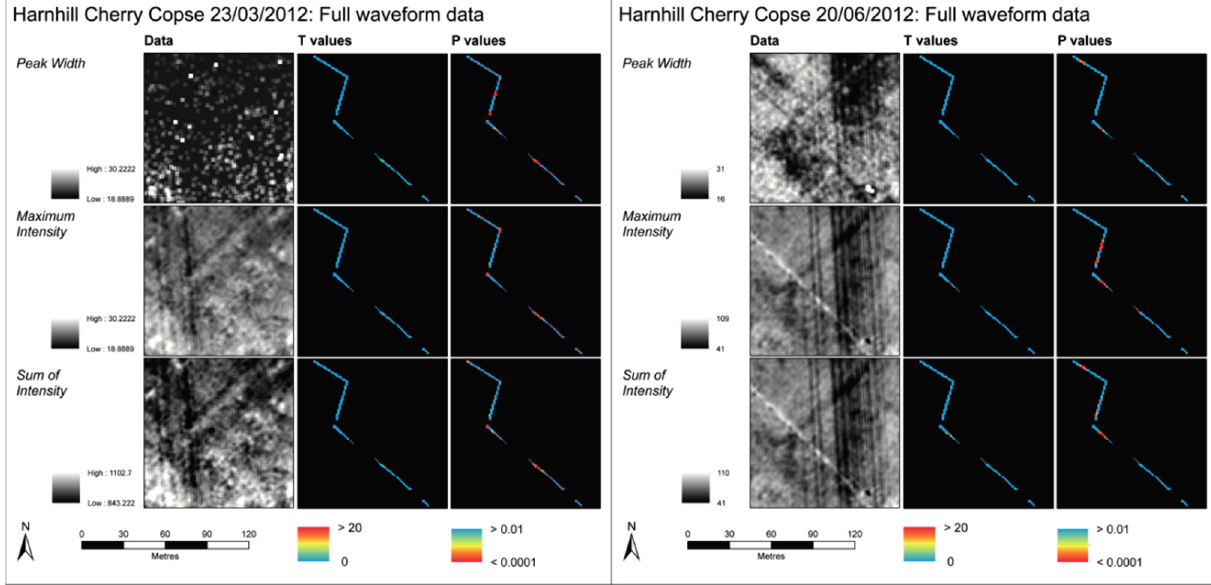
Figure 11. Metrics from airborne LiDAR full waveform data for Diddington Clay Field and T -values and P -values indicating localised contrast.